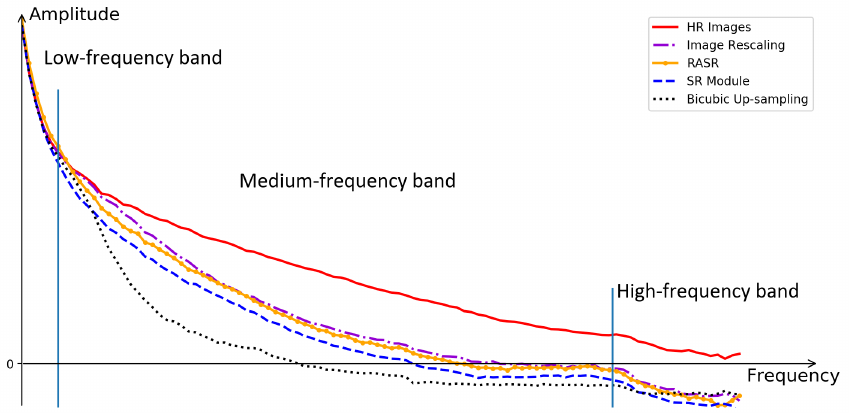
Figure 4. Amplitude–frequency curves of original HR images and the output images of RASR and its variants.